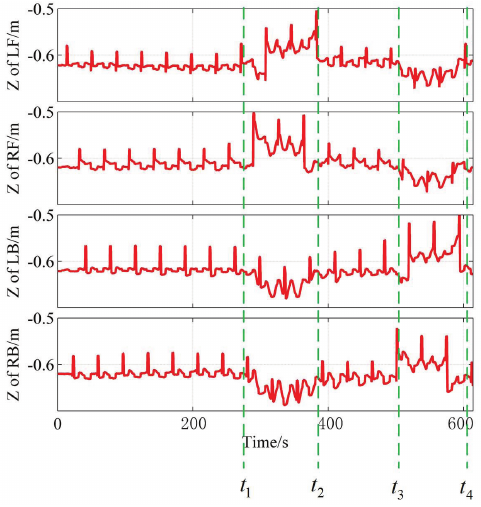
Figure 15. Z-coordinate of the foot in the coordinate system in the center of the robot body.